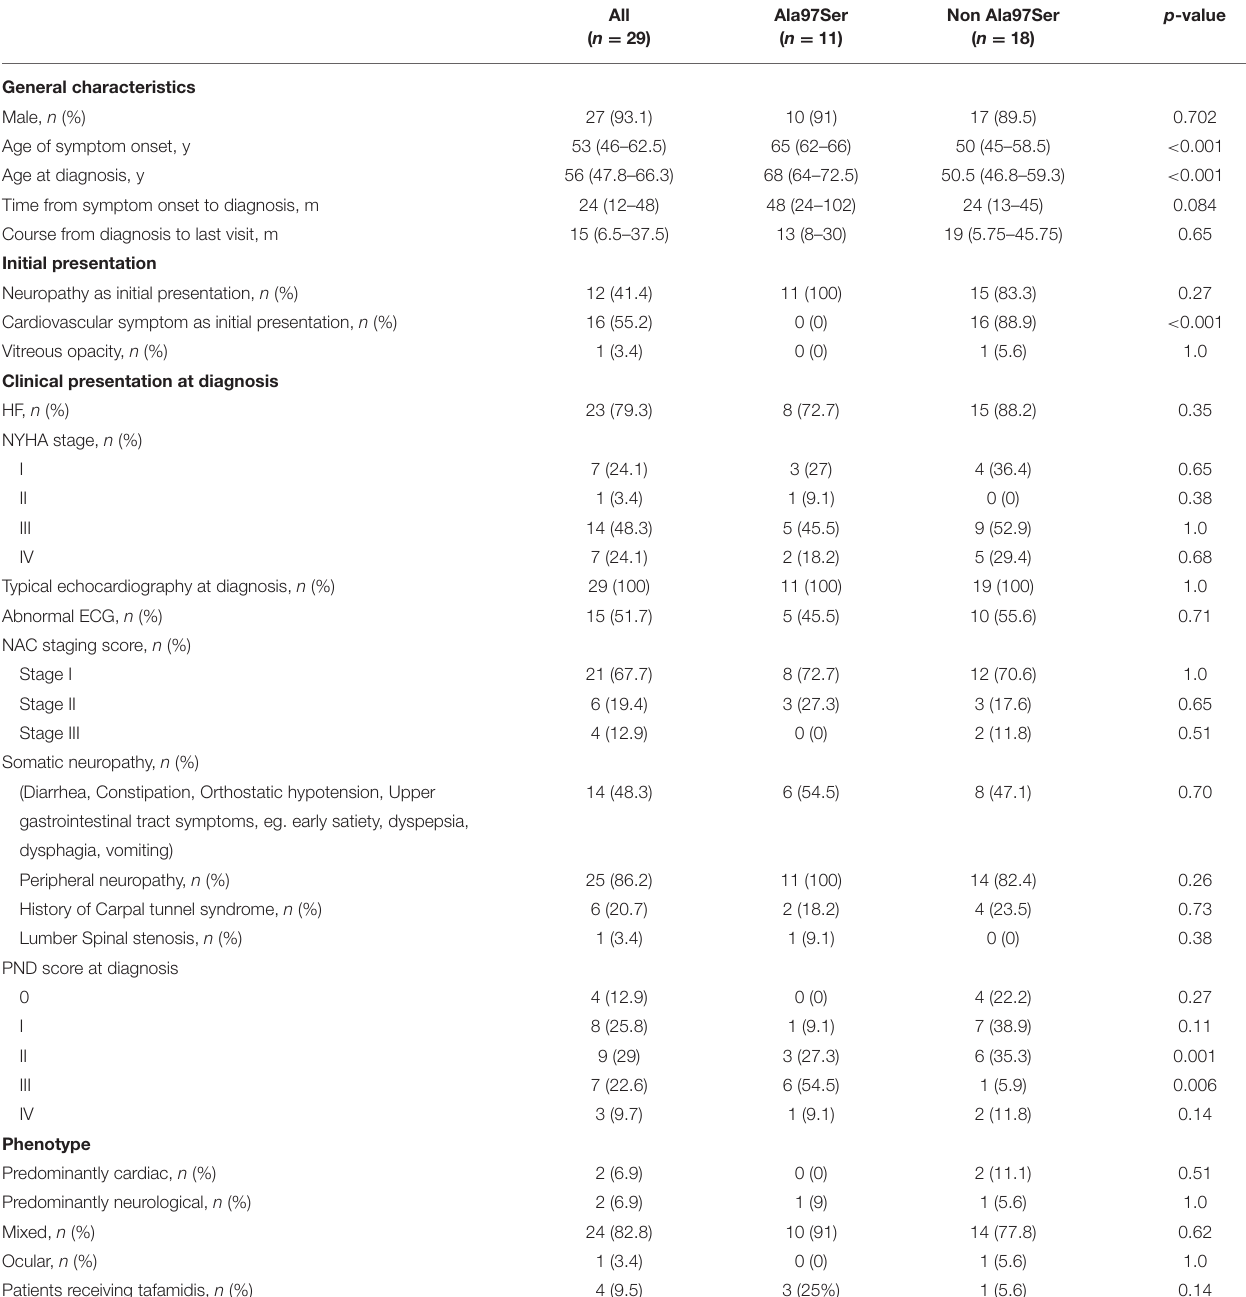
TABLE 1 | Clinical Manifestations of ATTRv-CM and the TTR variant Ala97Ser.